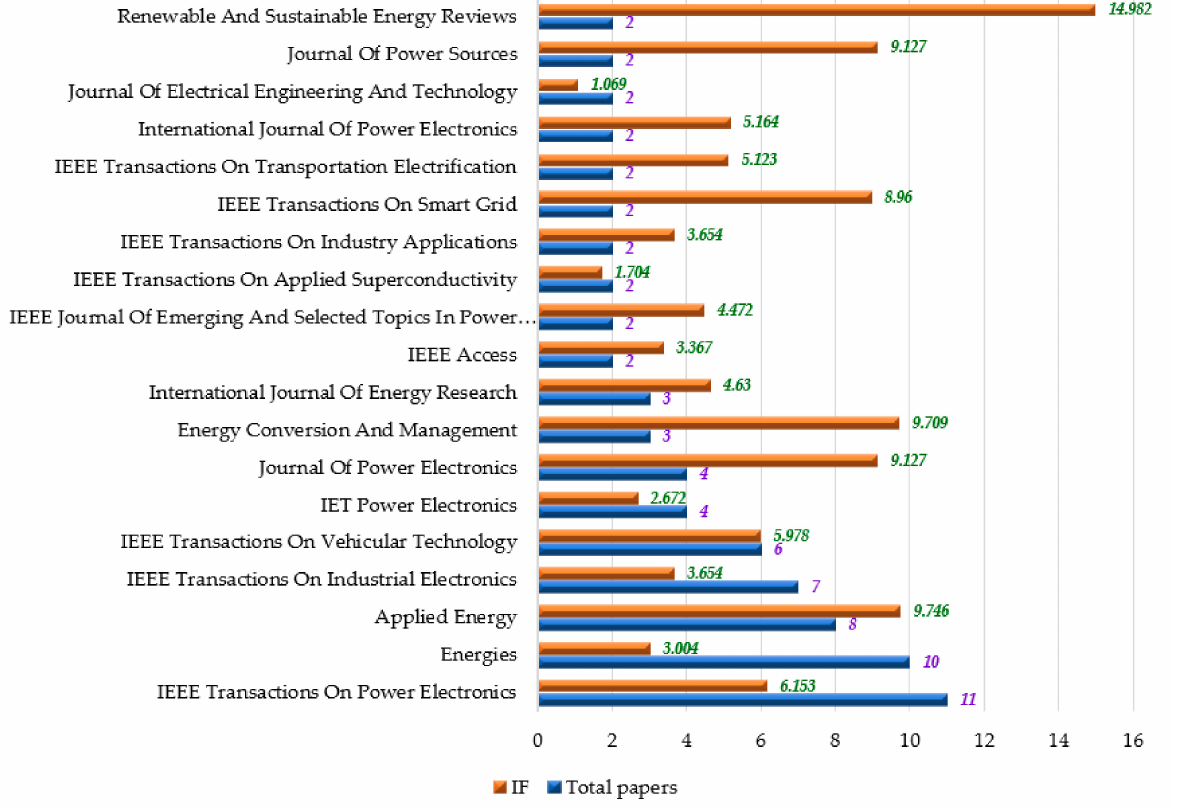
Figure 10. Distribution of manuscripts for Journal evaluation and Journal of impact